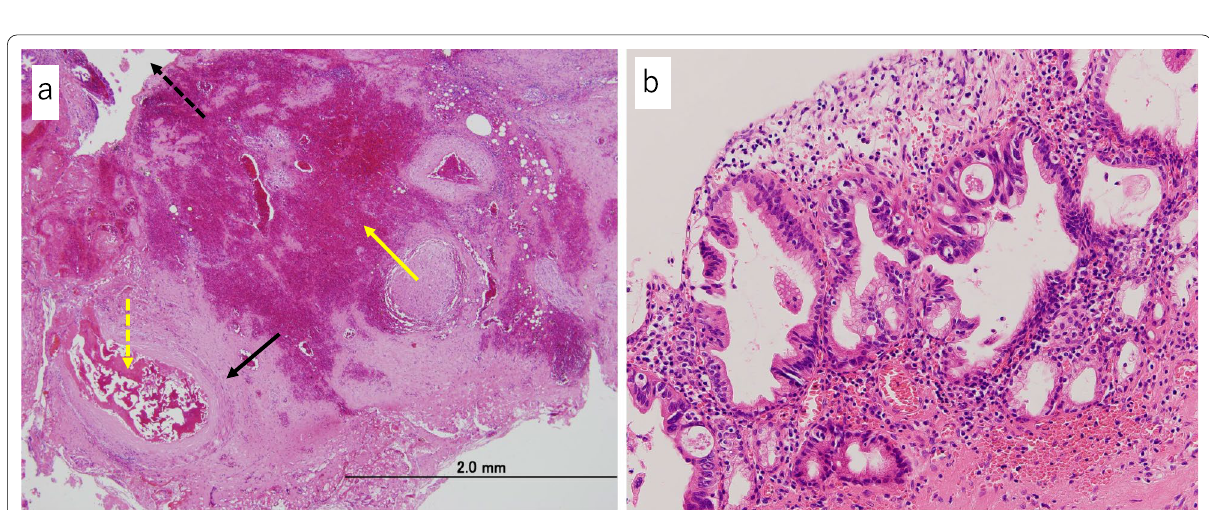
Fig. 6 Histological findings following hematoxylin and eosin staining. a Hemorrhage under the bile duct epithelium (dotted black arrow) at a site irrelevant to the CIS. Embolic material (dotted yellow arrow) is observed in the ruptured artery (solid black arrow), which is interpreted as the cause of hemorrhage. Hemorrhage site (solid yellow arrow) is accompanied by vascular proliferation that is considered to have existed before the hemorrhage. b Image of the CIS. No ulcer was